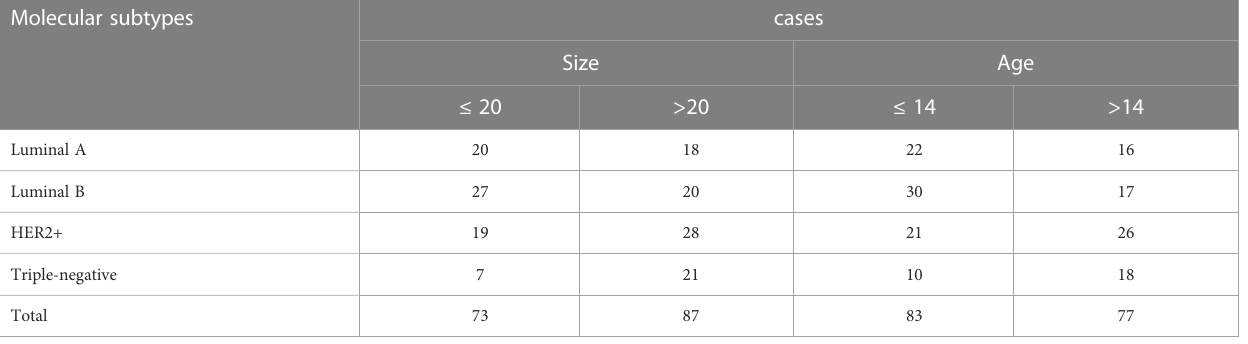
TABLE 1 The number of each sub-dataset in the dataset.